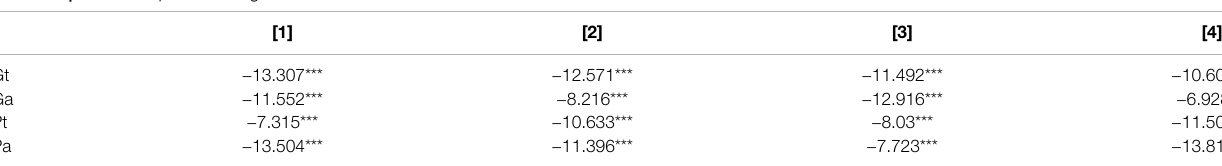
TABLE 5 | Results of panel cointegration